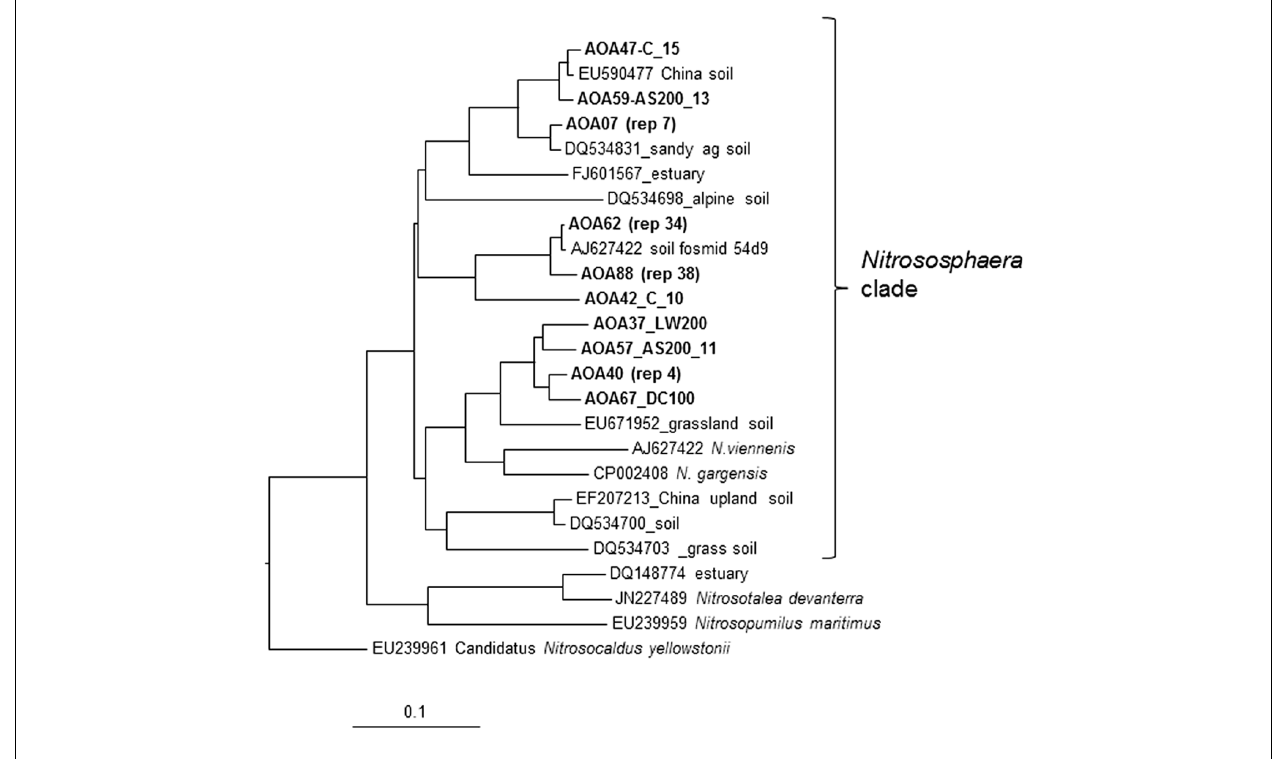
FIGURE 5 |Analysis of clone library sequences for archaeal amoA gene (570 bp). Neighbor joining tree for archaeal partial amoA sequences from soil samples that received ammonium sulfate (AS) dairy waste compost (DC) and liquid dairy waste (LW) at 100 and 200 kg available N ha − 1 annually for 6 years. Scale represents number of changes per 100 bp. Sequences